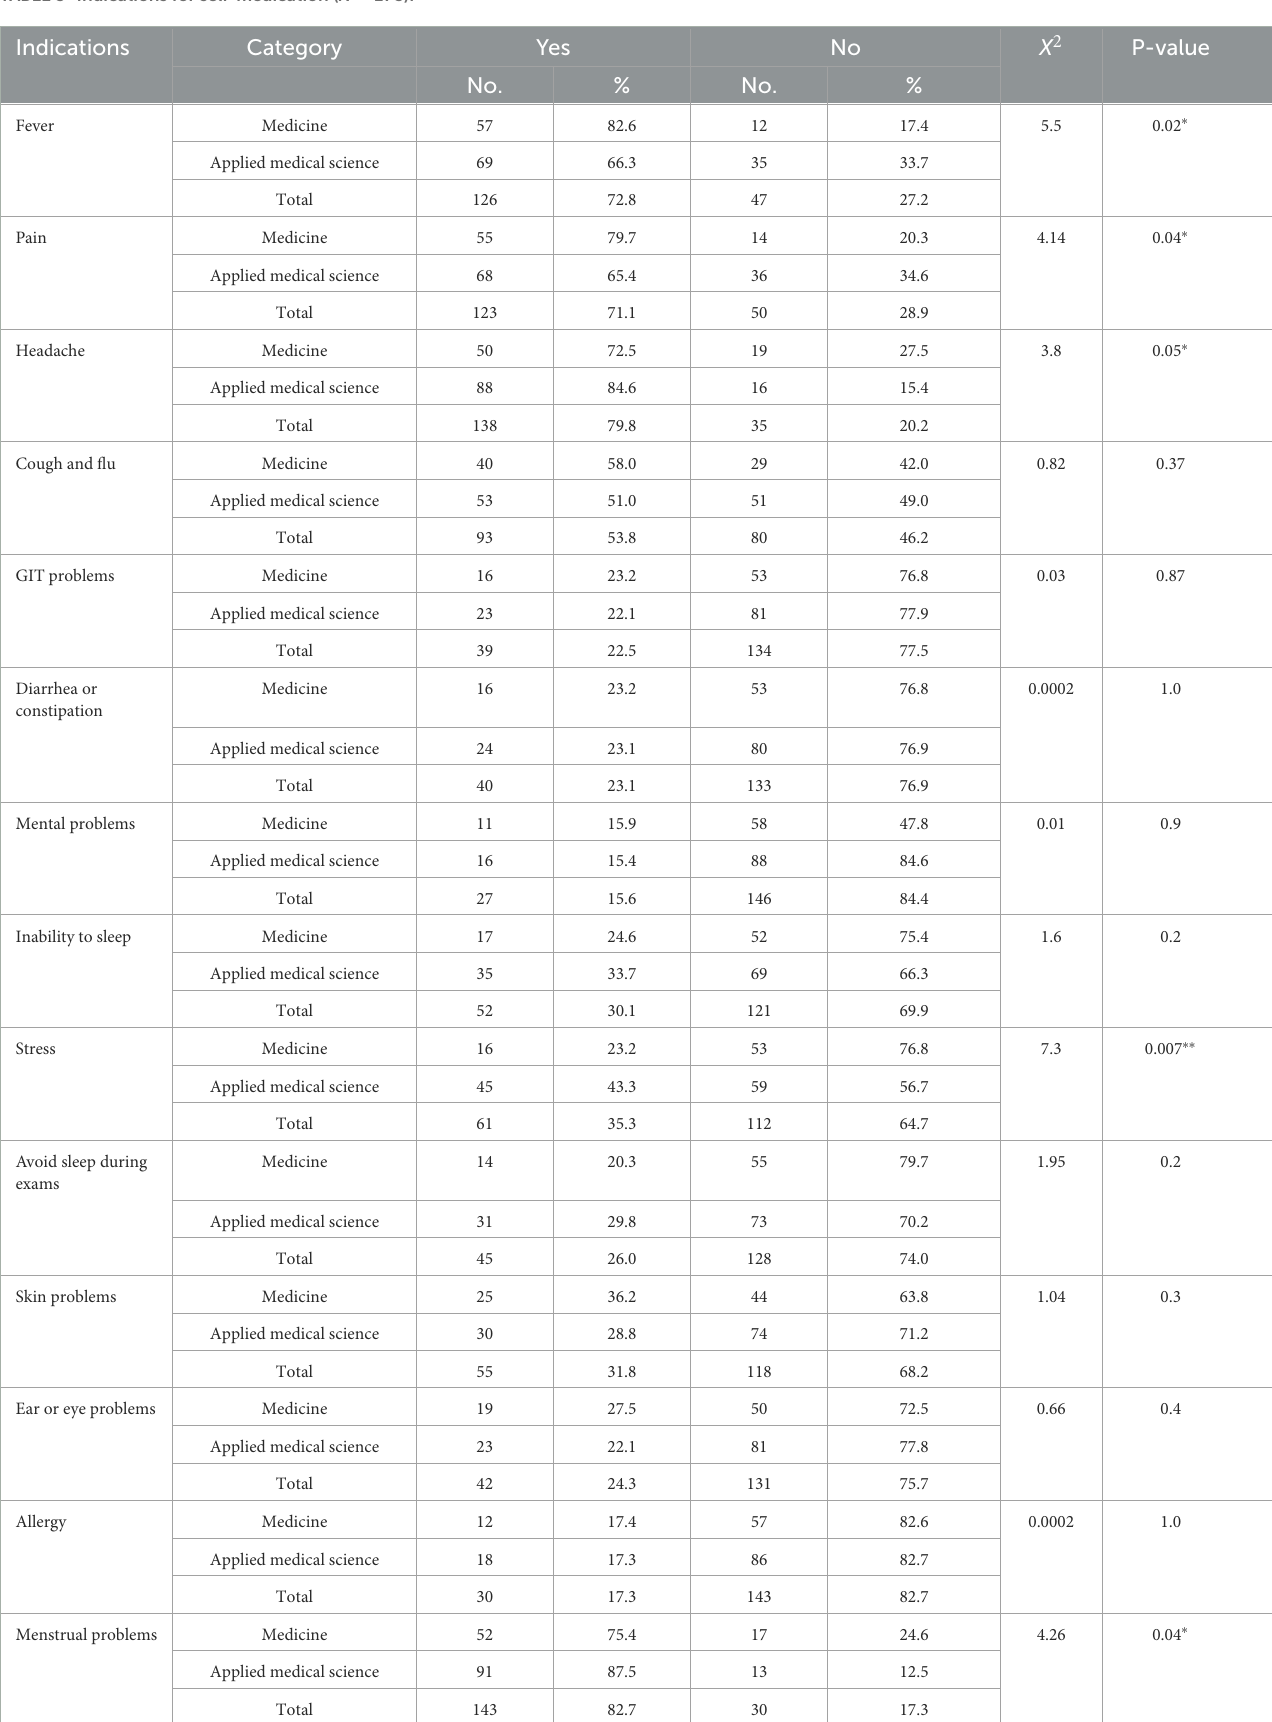
TABLE 3 Indications for self-medication ( N =